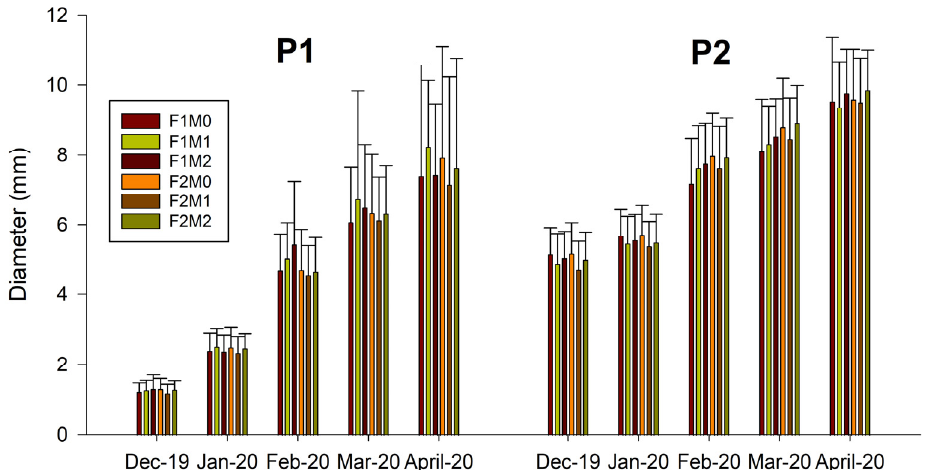
Figure 2. Shoot diameter of Nothofagus alessandrii plants of one and two seasons (P1 and P2) under di ff erent combinations of fertilization management (F1 and F2) and application of MFI (M0, M1, and M2).